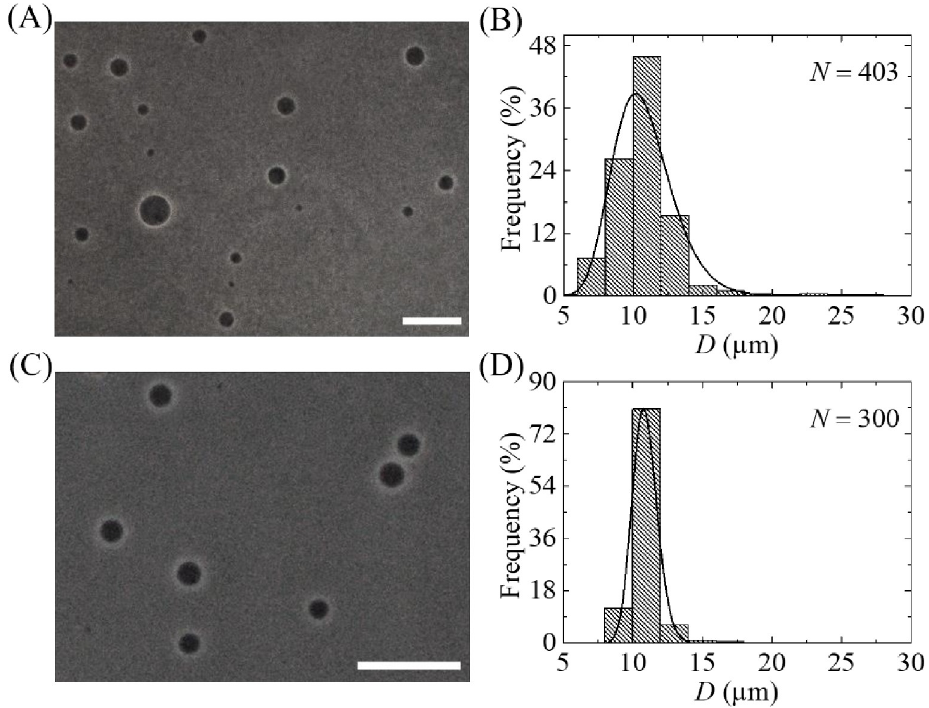
Fig 11. Effects of repeated purification on the phase contrast images and the size distribution of 40%DOPG/60% DOPC-GUVs for case (i). (A) and (B) show the phase contrast image and the corresponding size distribution histogram of GUVs in filter holder 2 after first purification. (C) and (D) show the phase contrast image and the corresponding size distribution histogram of GUVs in filter holder 2 after second purification. The purification was performed at flow rate 1 mL/min for 1 h. The bar in the images (A, C) corresponds to a length of 50 μ m. The solid line of B and D corresponds to fitting with Eq 1.